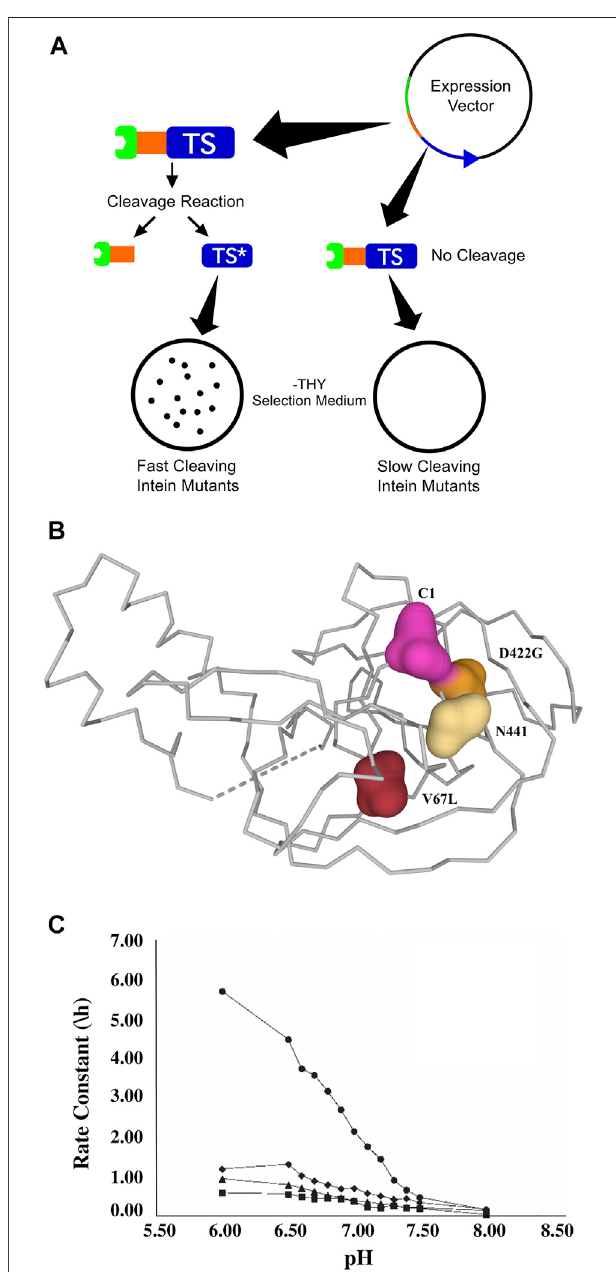
FIGURE 4 | C-terminal Asn residue inhibit the C-terminal cleaving step of the splicing reaction until after extein ligation. The D422G mutation removes this interaction and thus facilitates C-terminal cleavage in the absence of extein ligation. The additionalV67Lmutation confers stability onthe mini-intein created afterthedeletionofthehomingendonucleaseregion,allowingnative-likesplicing activity to be restored in the mini-intein. C1 and N441 indicate superimposed locations of N-terminal and C-terminal intein residues, respectively. (C) . This fi gure shows the effect of pH on cleavage activity of the mini-intein mutants discussed in the patent. The plotted rate constants are for cleavage of tagged target protein to products at 37 ° C and the indicated pH (Wood et al., 1999). In the fi gure, ◆ is the full-length wild-type intein, ▪ is the rationally engineered Δ I (cid:129) mini-intein, * is the Δ I mini-intein with the V67L mutation, and is the Δ I mini- intein with the D422G mutation (referred to as Δ I-CM). It was observed that cleavageratesincreasedasthepHwasreduced,typicallyincreasingbyafactor of 8 or more as the pH was decreased from 8.0 to 6.0. The strongest pH activation was exhibited by the Δ I-CM intein, for which the cleavage rate increasedbyafactorofmorethan20overthispHrange.Thecleavageinhibition